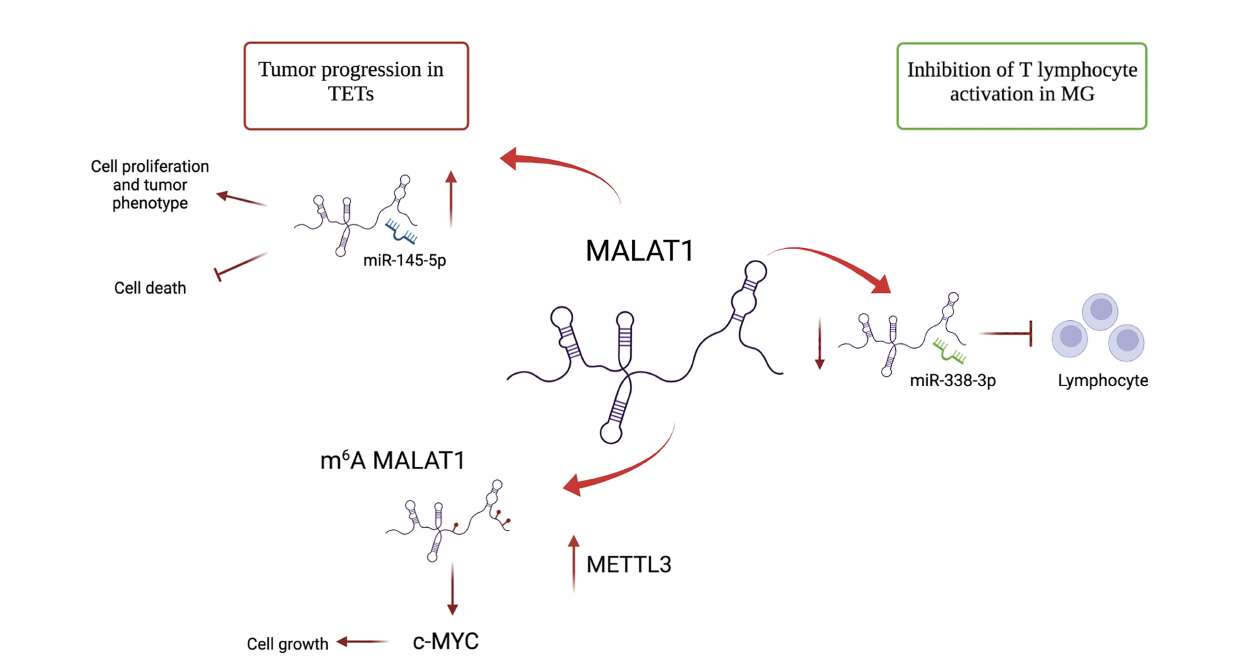
FIGURE 2 | Different roles of lncRNA MALAT1 in TETs and MG. MALAT1 has an oncogenic role in TETs. It promotes cell proliferation by acting as a sponge of miR- 145-5p. MALAT1 is m 6 A-modi fi ed due to METTL3 overexpression in TET and induces c-MYC protein, further contributing to proliferation. In MG, MALAT1 plays a protective role by binding mir-338-3p and avoiding T lymphocyte activation.